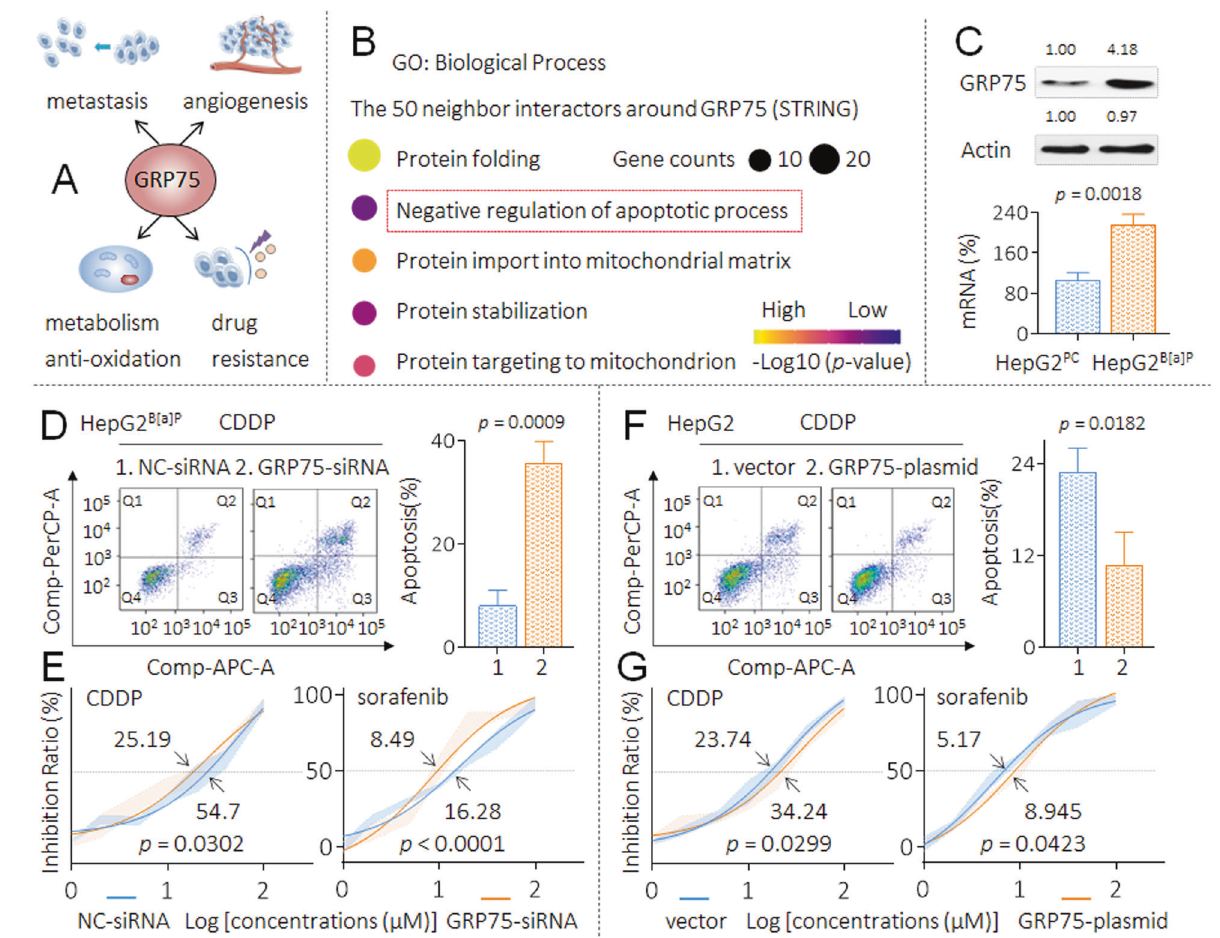
Fig. 2 Revealing a key anti-apoptotic molecule in HepG2 and HepG2 B[a]P cells. A Schematic diagram of the biological functions of GRP75 in HCC. B The top 5 GO biological processes of GRP75 and the 50 most frequently altered neighbor interactors around it. C Triplicate qPCR and western blot analysis of the mRNA and protein levels of GRP75 in HepG2 PC and HepG2 B[a]P cells. D and F After transfection, fl ow cytometric analyses of the percentage of cells in apoptosis under the treatment of 10.0 μ M cisplatin. E and G Transfected cells were treated with different concentrations of CDDP (0.0 to 100.0 μ M) and sorafenib (0.0 to 100.0 μ M) for 24 h, cell viability was determined in triplicate, and IC 50 s were